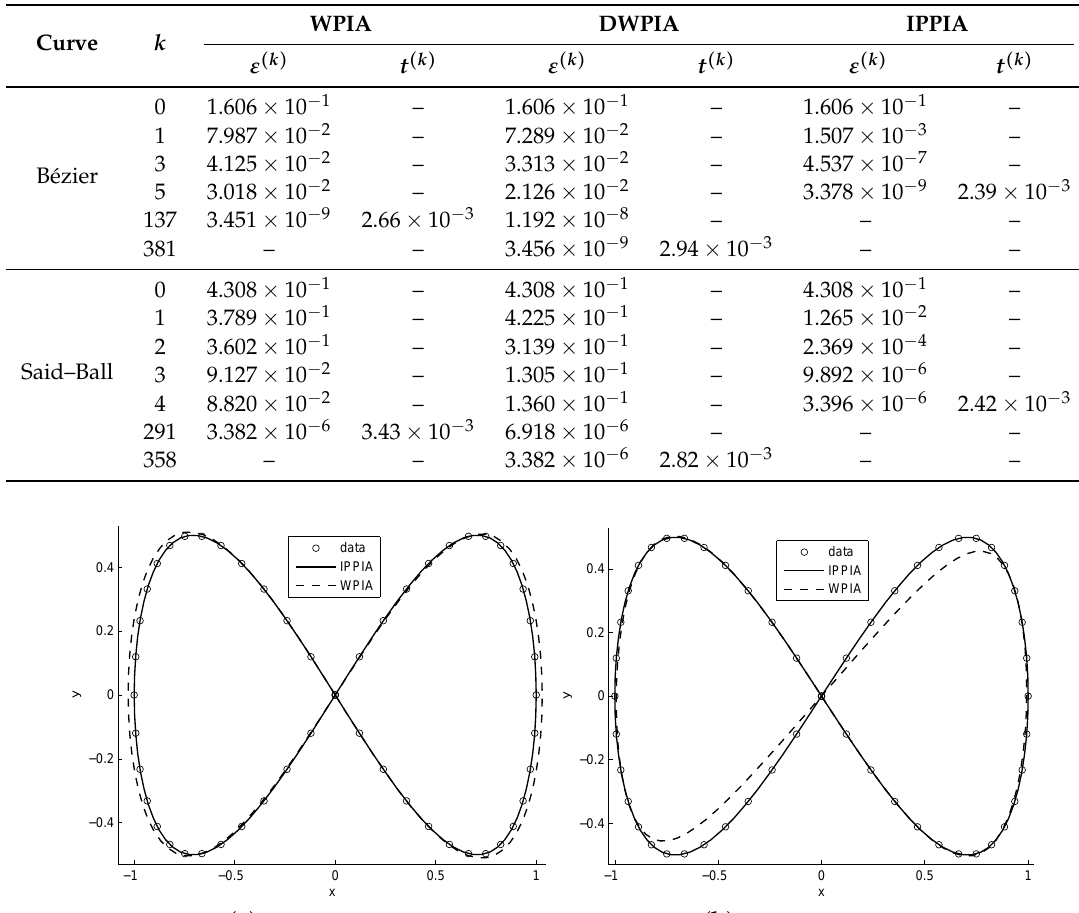
Table 6. Numerical results when fitting 53 points sampled from the lemniscate of Gerono. Curve